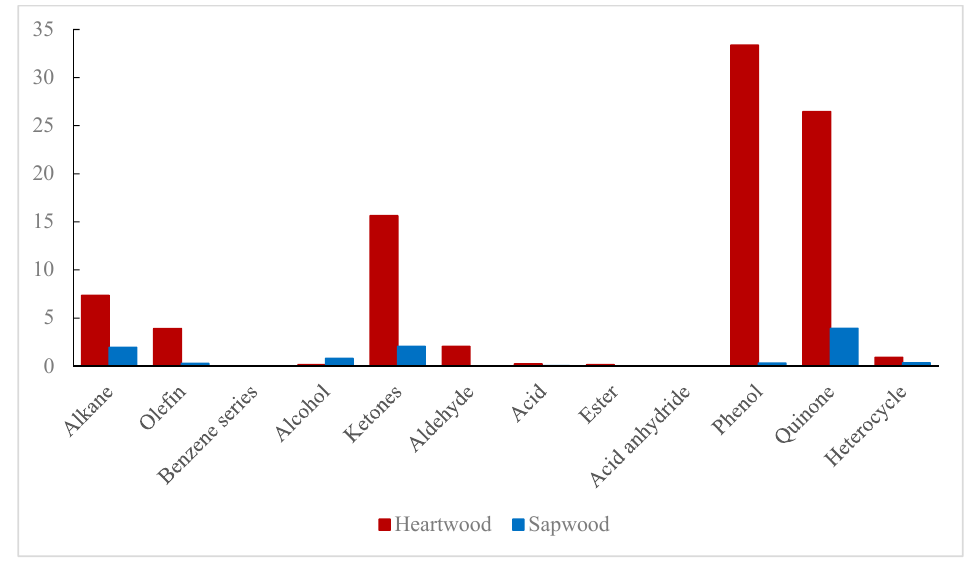
Figure 3. Contents of various compounds in acetone extractives in the heartwood and sapwood of teak. Table 6. The compounds in the heartwood and sapwood of teak with obvious difference in content.